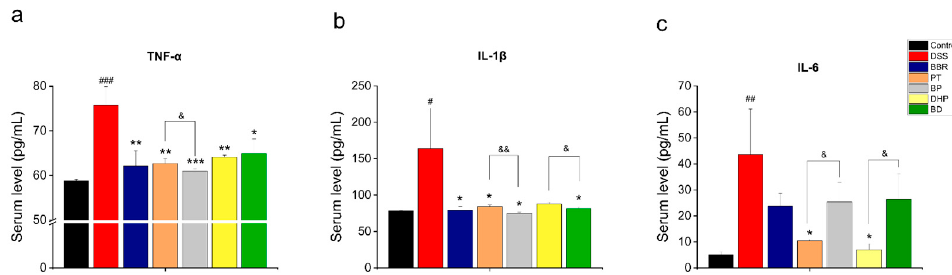
Figure 4. ( a ) The serum concentration of TNF- α ; ( b ) the serum concentration of IL-1 β ; ( c ) the concentration of IL-6. Significance between every two groups was calculated by using t -test. # p < 0.05, ## p < 0.01, ### p < 0.001, compared with the control group; * p < 0.05, ** p < 0.01, *** p < 0.001, compared with the DSS group; & p < 0.05, && p < 0.01, compared with the combination group.